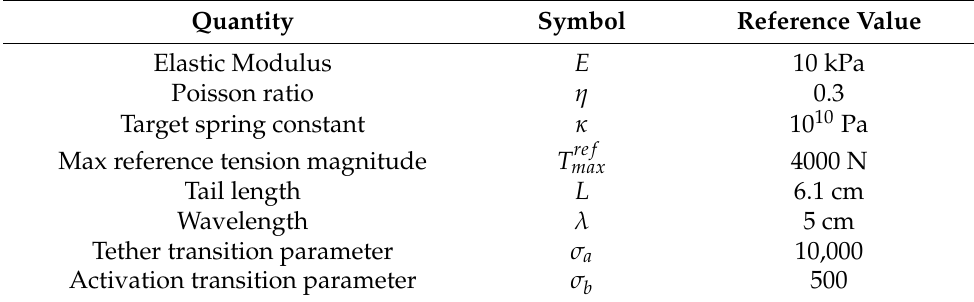
Table 1. Reference model parameters.